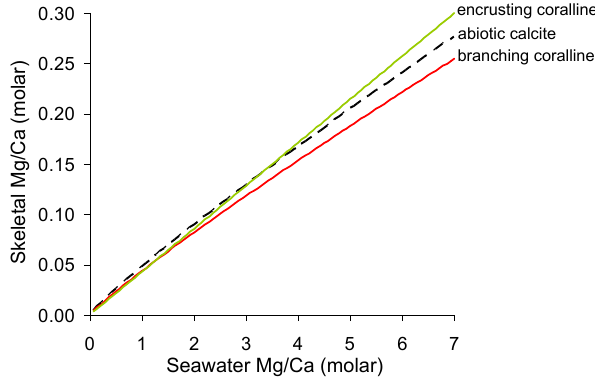
Fig. 24. Experimentally derived Mg fractionation curves for the encrusting coralline alga Neogoniolithon sp. (solid green curve; Mg/Ca C =0.0421Mg/Ca sw1 . 01 ) , for the three species of branch- ing coralline algae Amphiroa A, Amphiroa B, and Amphiroa rigida (averaged; solid red curve; Mg/Ca C =0.0582Mg/Ca sw0 . 904 ) , and for abiotically precipitated calcite (dashed black curve; Mg/Ca C =0.0482Mg/Ca sw0 . 898 ; F¨uchtbauer and Hardie, 1976). This reveals that Mg fractionation within coralline algae generally mimics that of abiotic calcification. Mg fractionation curves were calculated using least squares regressions. From Ries